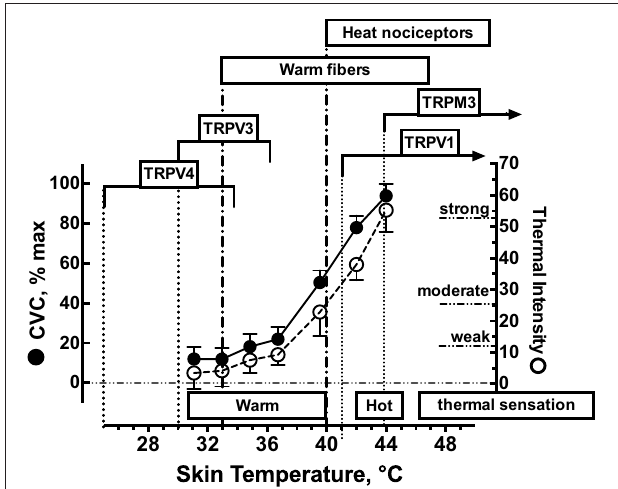
FIGURE 1 | Functional relationship between local skin temperature, cutaneous vascular conductance (CVC), and ratings of thermal sensation in human skin. Approximate temperature spans of the transient receptor potential vanilloid (TRPV) heat receptors based on the reported thermal sensitivities confirmed in whole-cell patch clamp recordings. Temperature spans of cutaneous thermoreceptors are based upon microneurographic measurements of afferent nerve traffic and local skin temperature. Values for CVC and ratings of thermal sensations are represented as mean ± 1 SD for n = 12